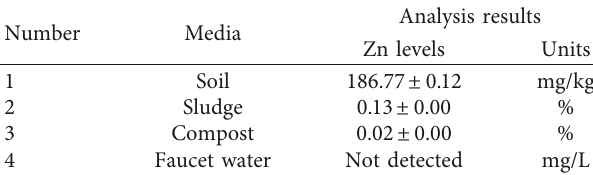
Table 1: Zn test results on planting